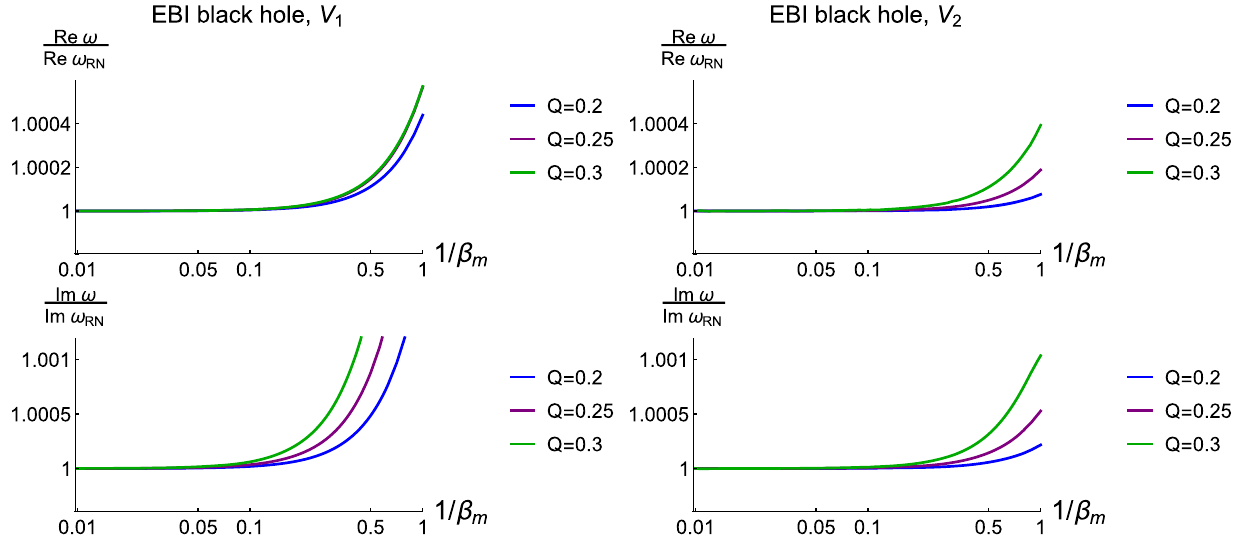
Fig. 1 The real part (upper) and imaginary part (lower) of the fundamental QNM frequencies of the EBI black holes are presented with respect to 1 /β m . The results are based on the potential V 1 (left) and V 2 (right), and the multipole number is fixed to l = 2